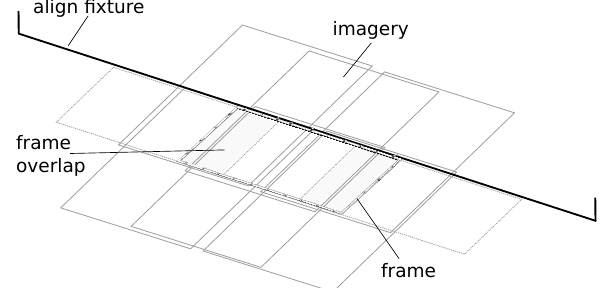
Figure 1: Roughness acquisition scheme and image arrangement for stereo coverage of the frame